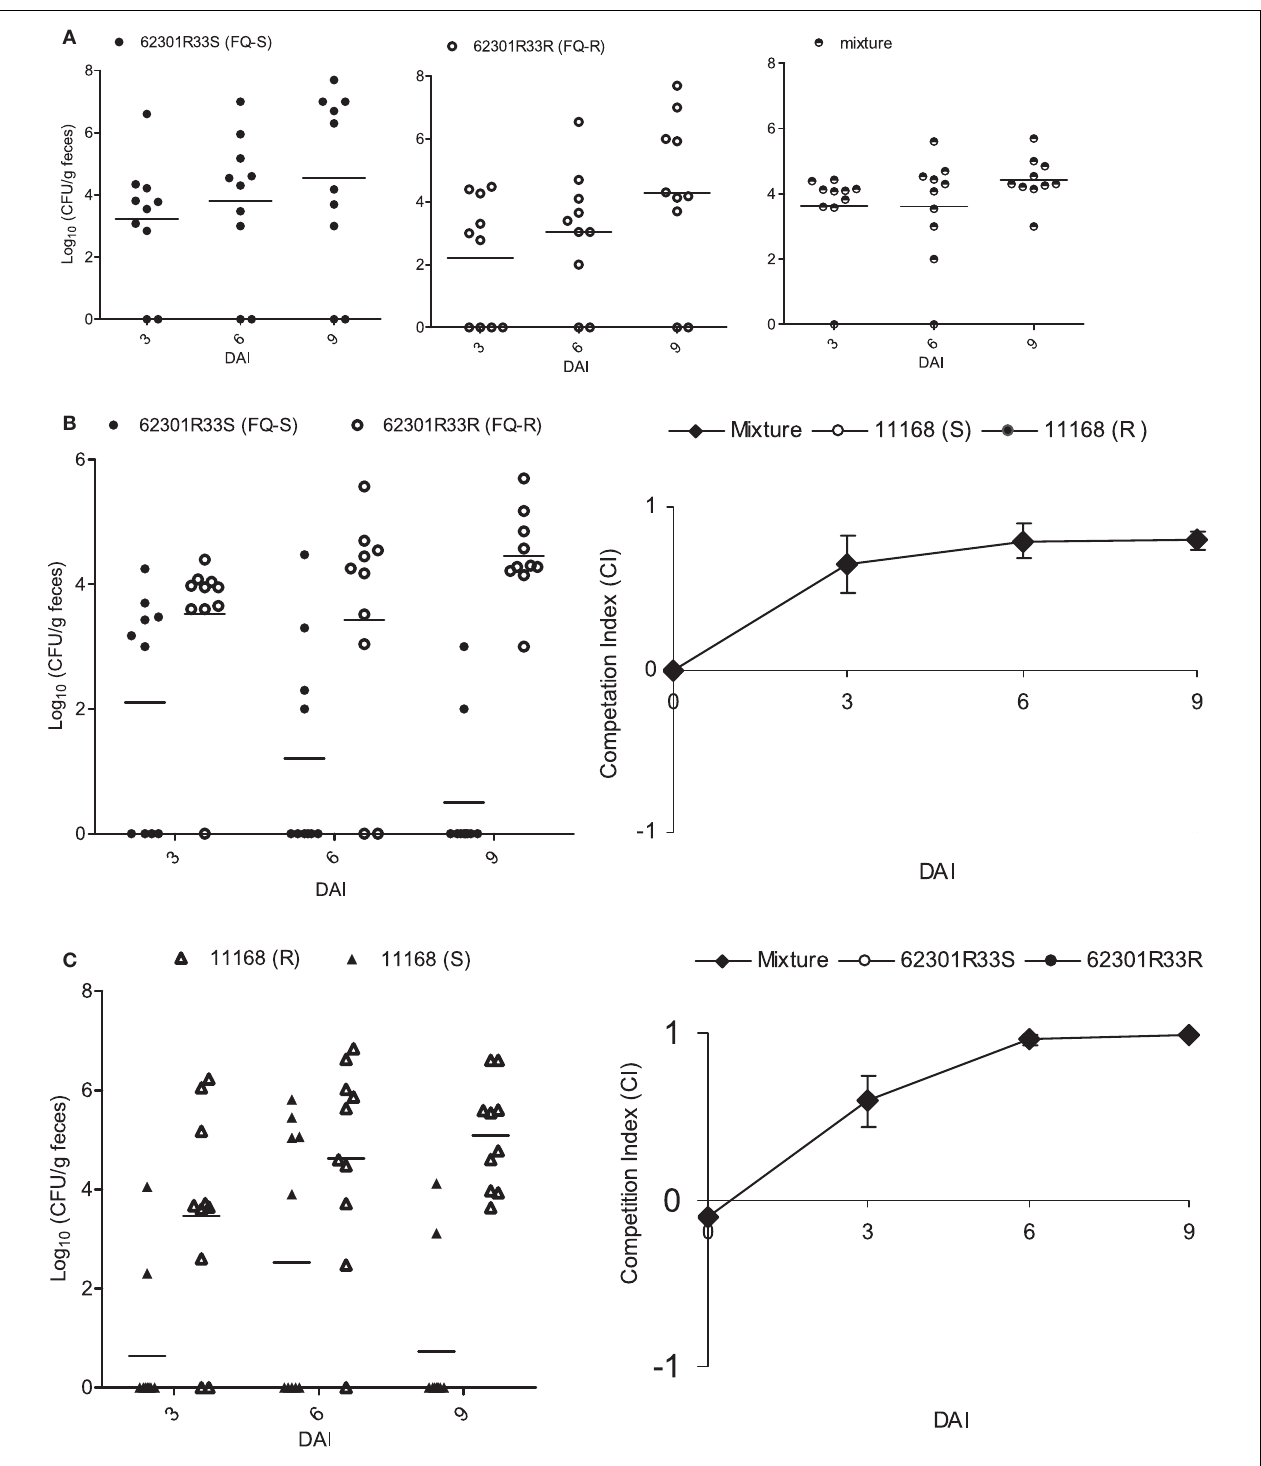
chicken experiment shows the competition between FQ S (solid triangle) and FQ R (open triangle) Campylobacter in a different strain background.The chickens were inoculated with a 1:1 mixture of 11168(S) and 11168(R). In all panels, each symbol represents the colonization level of a single chicken and the median level of each group is indicated by a horizontal bar.The detection limit of the plating method was about 100CFU/g of feces and a negative sample was arbitrarily assigned a value of zero. DAI, days after